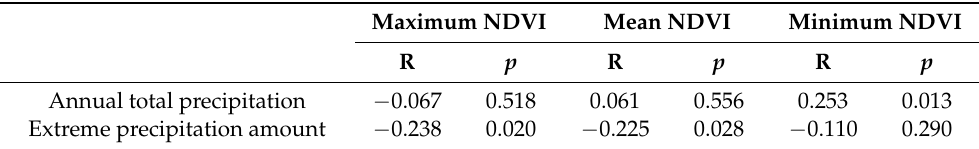
Table 2. Correlations between annual total precipitation, precipitation amount of extreme precipita- tion events and three NDVI-based